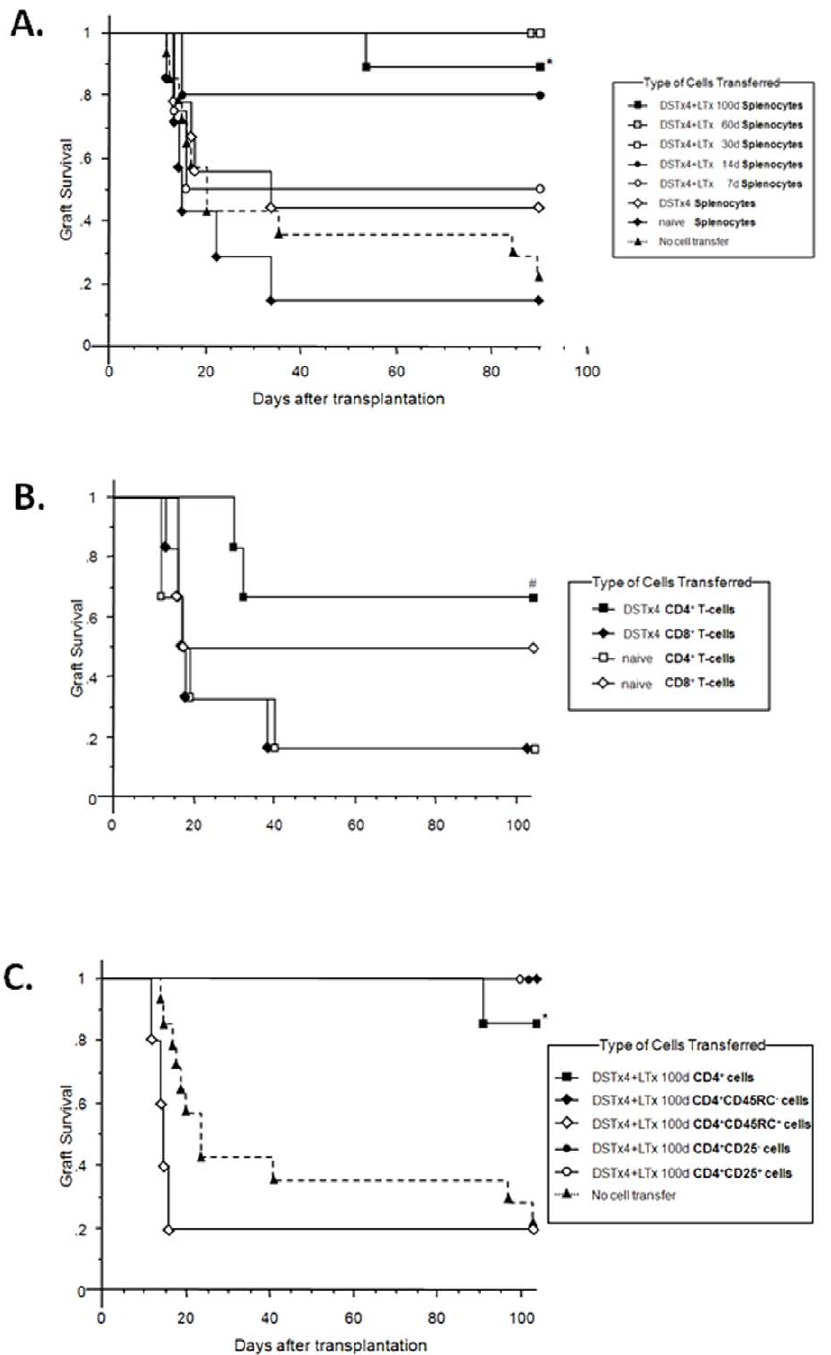
Figure 6. Allograft survival following adoptive transfer of splenocytes or indicated T-cell subsets obtained from different treatment groups. (A) Adoptive transfer of whole splenocytes from DSTx4 + LTx rats induces tolerance to liver allografts in naı¨ve LEW recipients in a time-dependent manner. Splenocytes (250 6 10 6 cells) obtained from naı¨ve (black diamonds, n=7), DSTx4 (white diamonds,n=9), DSTx4 + LTx at 7 d post LTx (white circles, n=4), DSTx4 + LTx at 14 d post LTx (black circles, n=5), DSTx4 + LTx at 30 d post LTx (white squares, n=4), DSTx4 + LTx at 60 d post LTx (hash squares, n=4) or DSTx4 + LTx at 100 d post LTx (black squares, n=9) were injected into lightly-irradiated (100rad) LEW rats one day before LTx. Control rats received 100 rad irradiation and received LTx but no cell transfer (black triangles, n=14). *P , 0.05 compared with no cell transfer. (B) Adoptive transfer of CD4 + but not CD8 + T-cells obtained from DST-primed LEW rats induces tolerance to liver allografts in naive LEW recipients. CD4 + (white squares, n=6) or CD8 + (white diamonds, n=6) T-cells (50 6 10 6 cells) obtained from spleens of naı¨ve rats and CD4 + (black squares, n=6) or CD8 + (black diamonds, n=6) T-cells (50 6 10 6 cells) obtained from spleens of DSTx4 rats were injected into lightly-irradiated (100 rad) LEW rats one day before LTx. # P=0.05 compared with naı¨ve CD4 + (white squares). (C) Adoptive transfer of CD4 + CD45RC 2 , CD4 + CD25 + or CD4 + CD25 2 T-cells induces tolerance to liver allografts in naı¨ve LEW recipients. CD4 + T-cells (50 6 10 6 cells; (black squares, n=7); CD4 + CD45RC 2 T-cells(20 6 10 6 cells; black diamonds, n=5); CD4 + CD45RC + T-cells (20 6 10 6 cells; white diamonds,n=5); CD4 + CD25 2 T-cells (40 6 10 6 cells; black circles, n=5); and CD4 + CD25 + T-cells (10 6 10 6 cells, white circles, n=5) from DSTx4 + LTx at 100days post LTx were transferred into lightly irradiated LEW rats one day prior to LTx. *P , 0.05 compared with no cell transfer (black triangles).